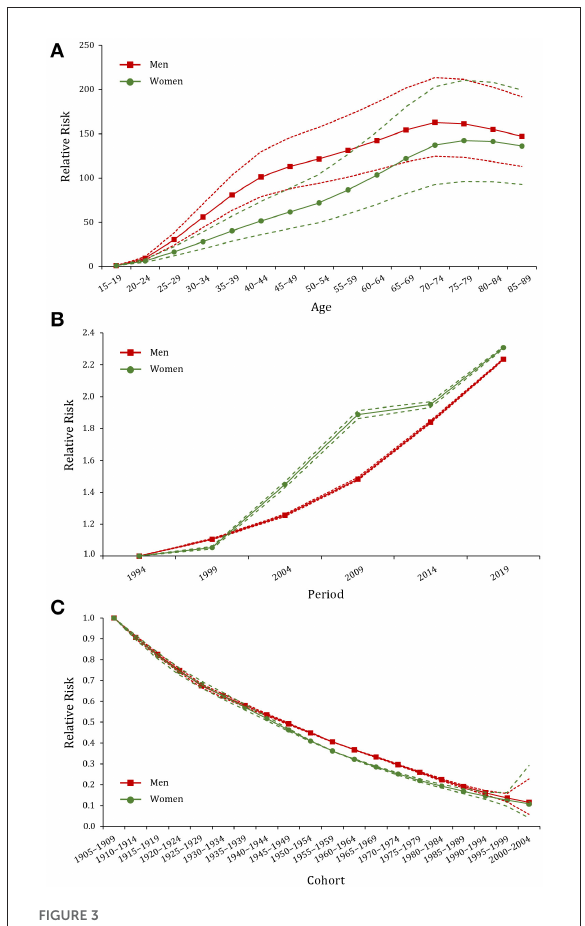
FIGURE3 Age, period, and cohort effects on the prevalence of gout in China during 1990–2019. (A–C) Age, period, and cohort effects, respectively; the red dot line represents the 95% confidence interval (CI) for men, and the green dot line represents the 95% CI for